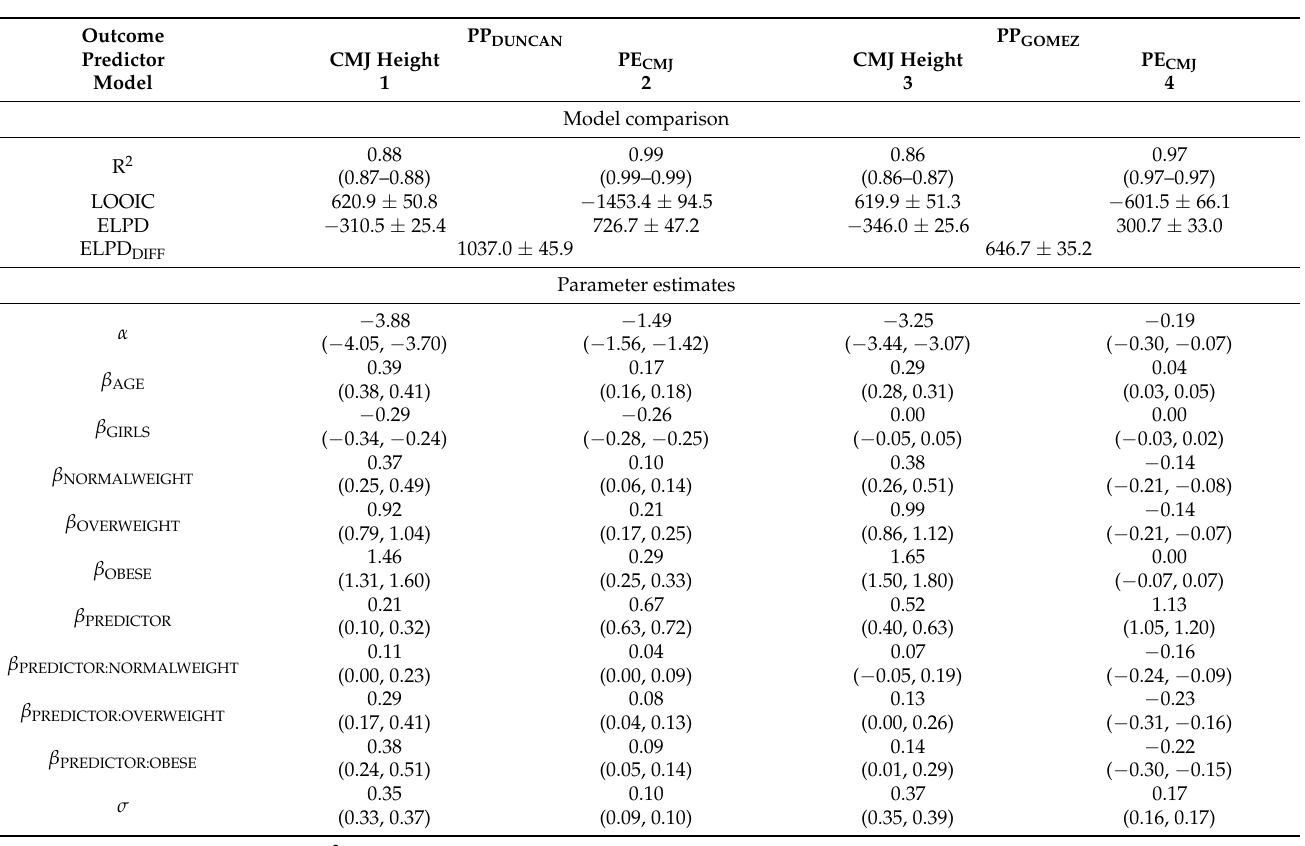
Table 2. Bayesian coefficient of determination (R 2 ), leave-one-out information criterion (LOOIC), expected log predictive density (ELPD), difference in ELPD between models with the same